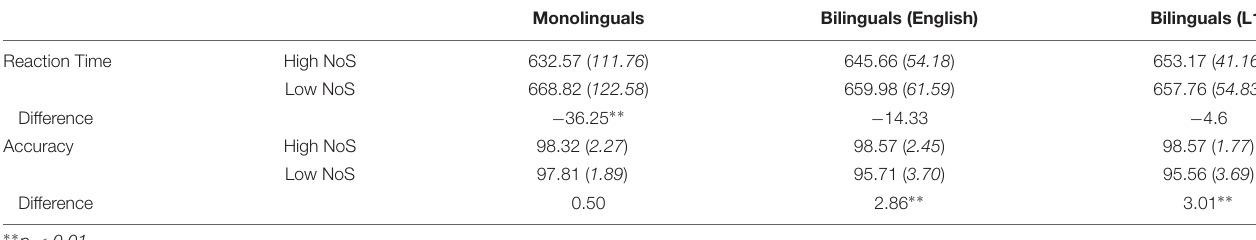
TABLE 4 | Mean RT (SD) and accuracy (SD) for monolinguals and bilinguals in the lexical decision task in English and in the L1 (bilinguals).